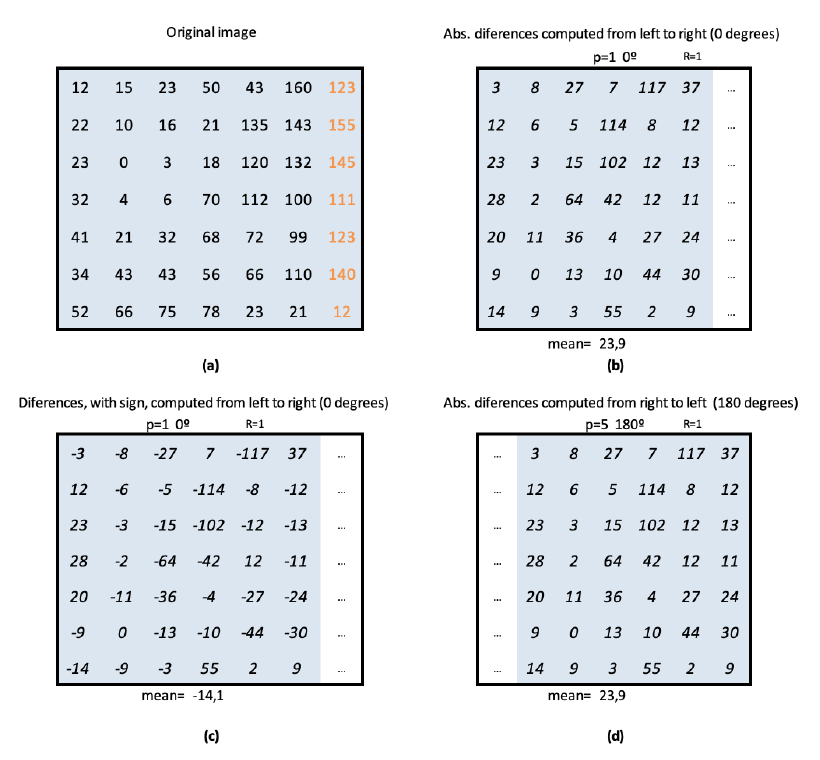
Figure 6. ( a ) Example of gray values of an Original Image. ( b ) Matrix obtained from the first difference of the gray values at 0 degrees. It corresponds with the first element of CLOSIB 8,1,1 . ( d ) Matrix obtained from the first difference of the gray values at 180 degrees. It corresponds with the fifth element of CLOSIB 8,1,1 . ( c ) Differences, with sign, at 0 degrees. CLOSIB uses the absolute value of the differences, therefore these values with sign are never